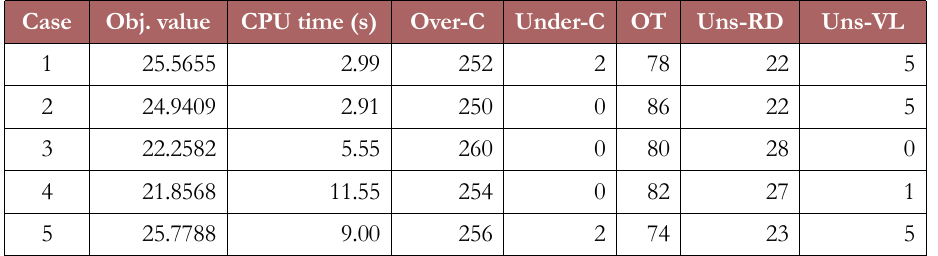
Table 13. Results of plugging penalty weights for all five (5)